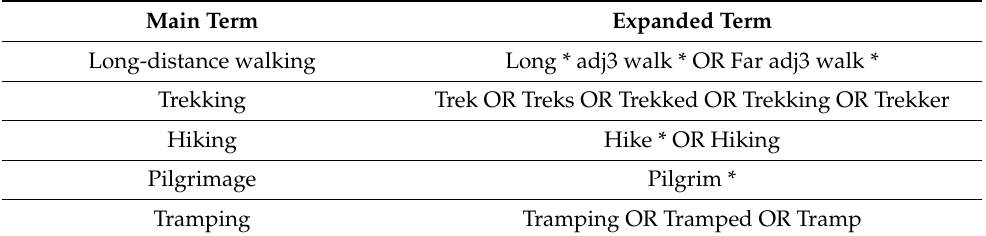
Table 1. The search strategy used in Medline, PsycINFO, and Embase for a scoping review on long-distance walking and mental